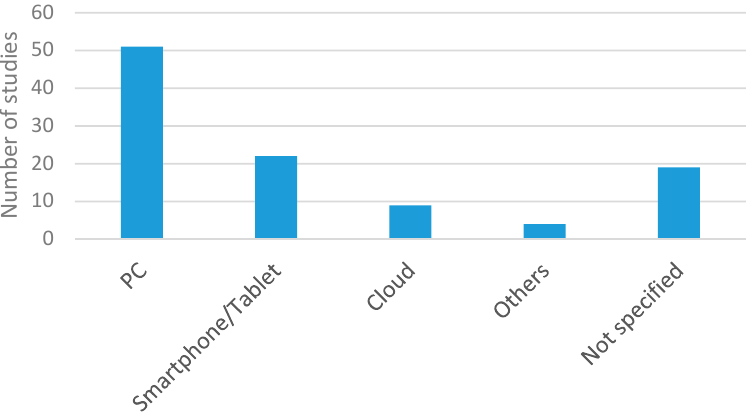
Figure 22. Number of studies adopting the di ff erent processing units.